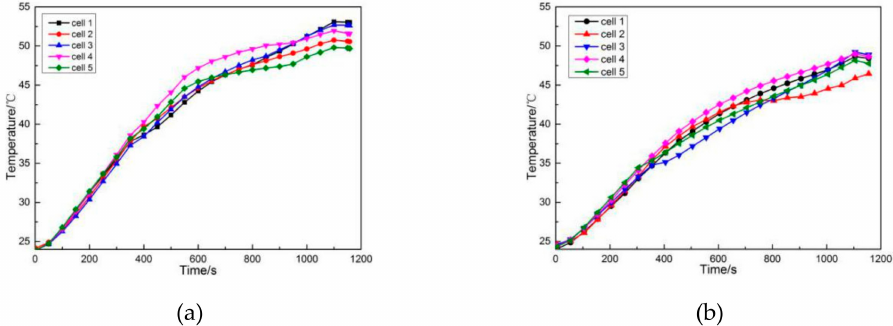
Figure 13. Surface temperature curve at 2C discharge rate under thermal management of di ff erent EG